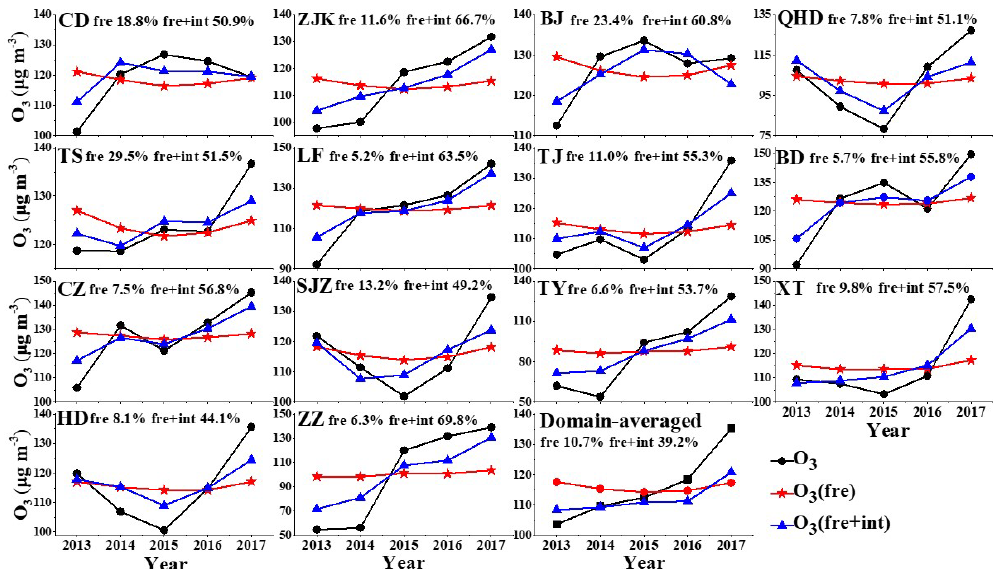
Figure 8. The interannual MDA8 O 3 concentration trends for observed and reconstructed O 3 based on variations in weather types in 14 cities. The black lines represent the observed interannual MDA8 O 3 trend, whereas the red and blue lines are the trends of reconstructed MDA8 O 3 concentrations according to the frequency-only and both frequency and intensity of weather type changes, respectively. The percentages in each city indicate the O 3 interannual variabilities influenced by frequency-only and by both frequency and intensity of weather type